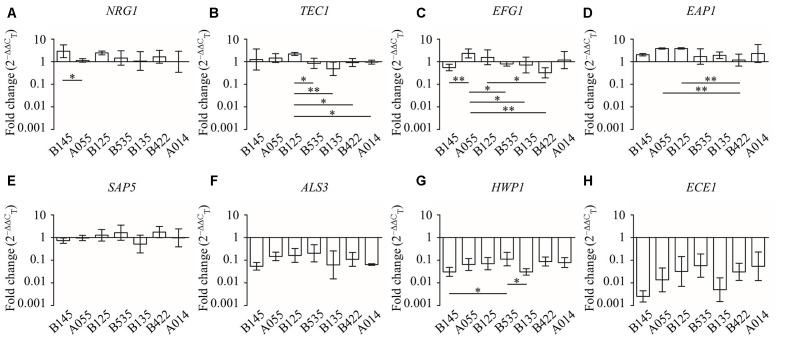
The expression levels (fold change) of virulence-related genes in C. albicans treated with seven different CFS from L. crispatus. (A)
NRG1, (B)
TEC1, (C)
EFG1, (D)
EAP1, (E)
SAP5, (F)
ALS3, (G)
HWP1, (H)
ECE1. Error bar represents SD from three biological replicates. Comparisons among multiple groups were performed by one-way ANOVA followed by LSD test. ∗P < 0.05, ∗∗P < 0.01.